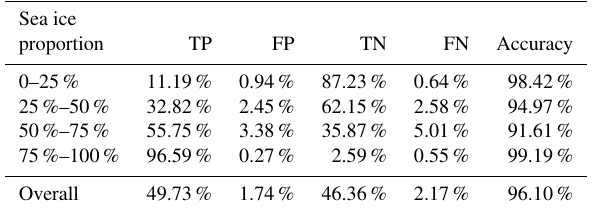
Table 1. Proportions of TP, FP, TN, FN, and accuracy of the S1- derived sea ice cover data evaluated by visual interpretation results of 96